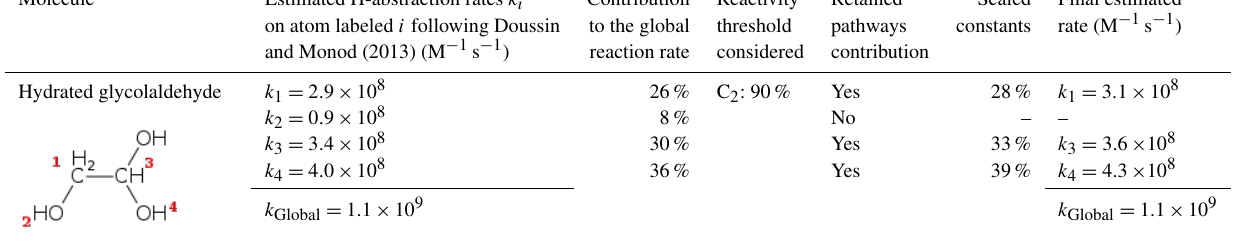
Table 2. Examples of the reduction scheme applied to estimate HO · reaction branching ratios. k i values are the partial reaction rate Table 2: Examples of the reduction scheme applied to estimate HO • reactions branching ratios. k i values are the partial reaction corresponding to the labeled atoms i in the left column. Table 2: Examples of the reduction scheme applied to estimate HO • reactions branching ratios. k i values are the partial reaction rate corresponding to the labeled atoms i in the left column. rate corresponding to the labeled atoms i in the left column. Table 2: Examples of the reduction scheme applied to estimate HO • reactions branching ratios. k i values are the partial reaction rate corresponding to the labeled atoms i in the left column. Estimated H-abstraction rates k i on atom labeled i Molecule following Doussin and Estimated H-abstraction rates k i on atom labeled i Molecule following Doussin and